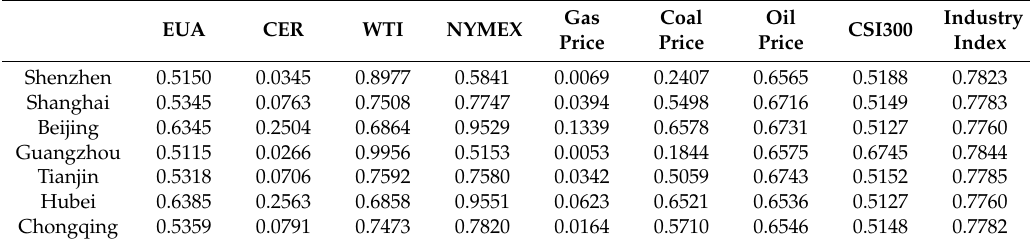
Table 6. Estimated degree of correlation in grey absolute relational model.